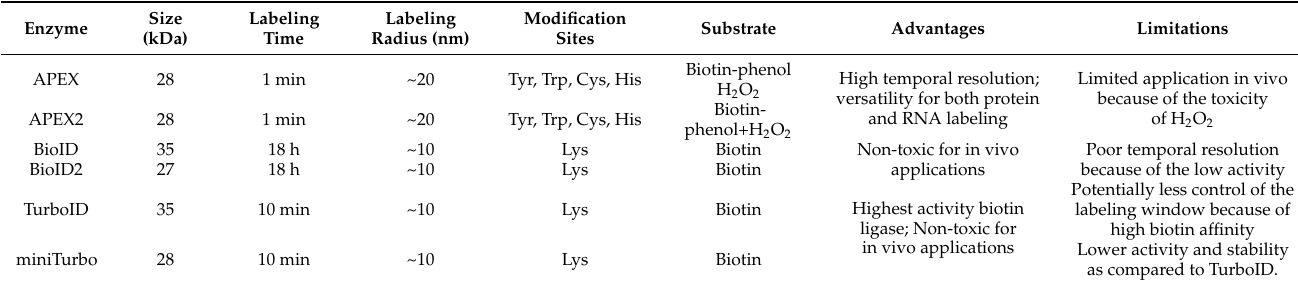
systematically analyzed. A novel protein TFG that regulates EGFR endosomal sorting has been identified [116]. We have systematically studied the PTK7 spatial interactome and found that its mechanism in drug resistance is related to NDRG1 [117]. Table 1. Overview of PL enzymes.